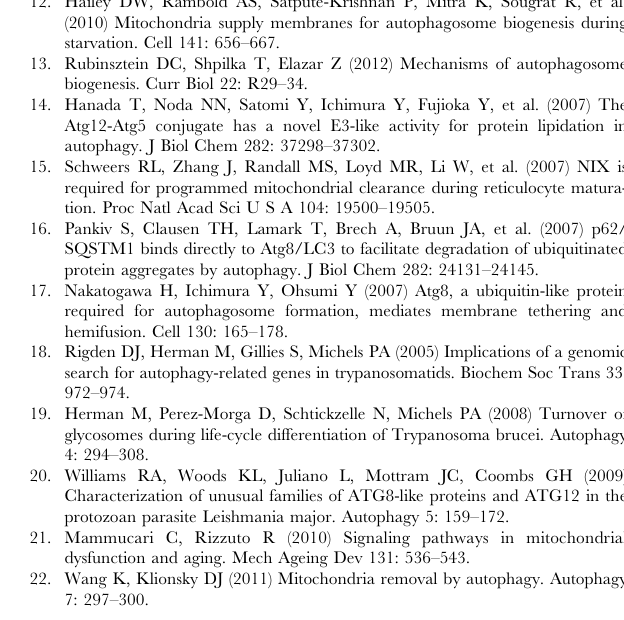
Figure S2 Comparison of PE species in WT and D atg5 promastigotes. Negative ion ES-MS survey scans (600– 1000 m/z) of lipid extracts with the addition of an internal standard PE (28:0) from WT (A) and D atg5 (B) promastigotes. Inserts are ESI-MS-MS positive ion spectra of neutral loss 141 m/ z, the internal standard PE (28:0) is indicated with by IS and an arrow. Figure S3 Analysis of D 3 -Ser incorporation into phos- pholipids in L. major promastigotes. To investigate if the observed increase in PE species in the D atg5 promastigotes was generated by PS decarboxylase activity, both WT (A) and D atg5 (B) promastigotes were grown in the presence of D 3 -serine prior to lipid extraction and analysis by negative ion ES-MS survey scans (650–900 m/z). Table S1 Phospholipid species in L. major . Lipids extracted from L. major were analyzed by ES-MS and subjected to MS/MS daughter ion spectra where necessary and assigned structures based upon their fragmentation ions and previous literature characterisations. Table S2 Plasmids and primers used in this